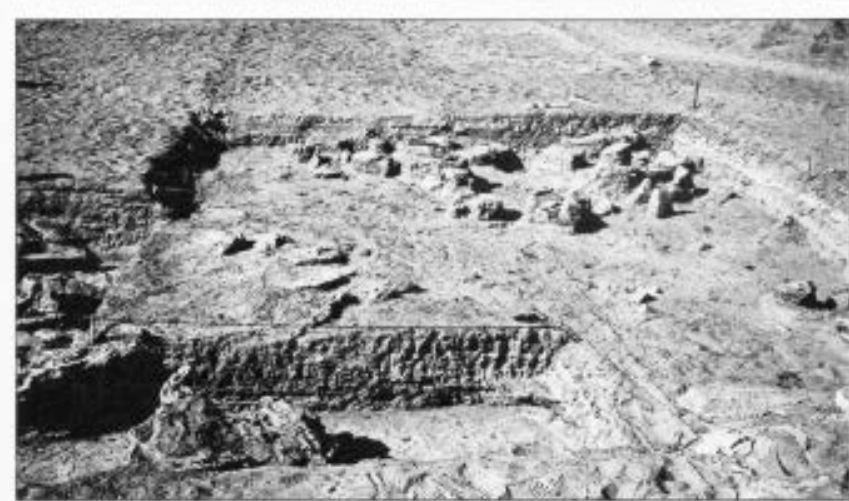
Figure 5 The foundations of one of the stone-lined circular huts at Bahr Playa in Hidden Valley that date to between 8000 and 7000 years ago.